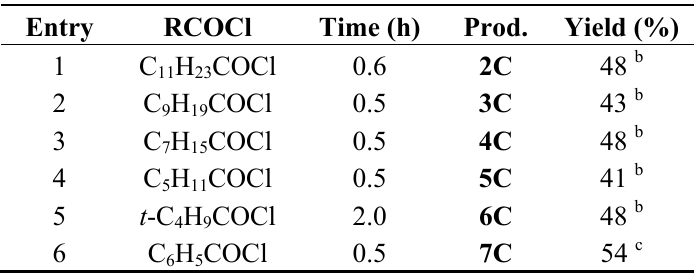
Table 2. Synthesis of the monoesters of M1 a